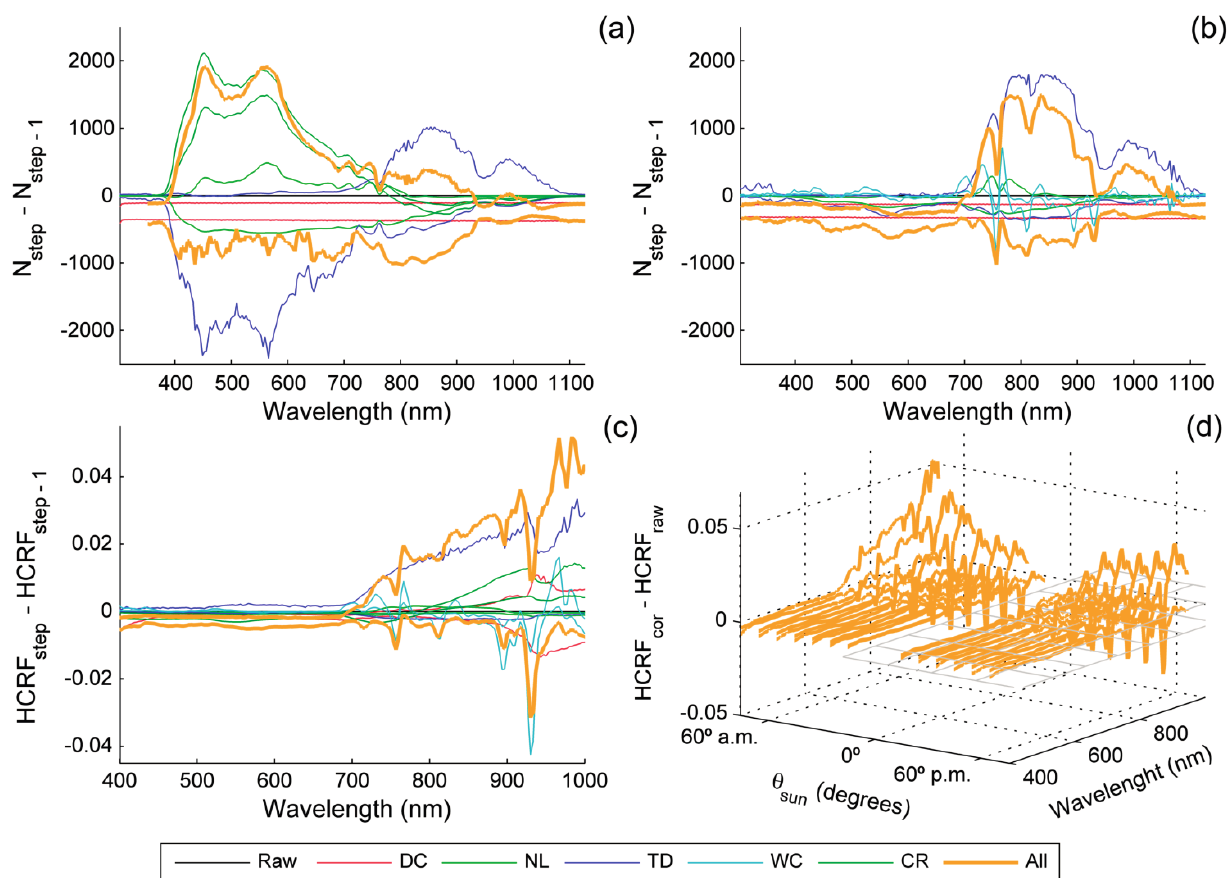
Figure 7. HCRF correction performed on 3730 spectra taken by the AMSPEC-Med system between the 1 August 2013 and 15 June 2014 in a single viewing position. Percentiles 99% of the changes introduced by each step of the correction respect to the previous stage are shown: ( a ) DN spectra in channel 1; ( b ) DN spectra in channel 2; ( c ) HCRF spectra; ( d ) HCRF spectra grouped in 10 degrees wide ranges of θ s